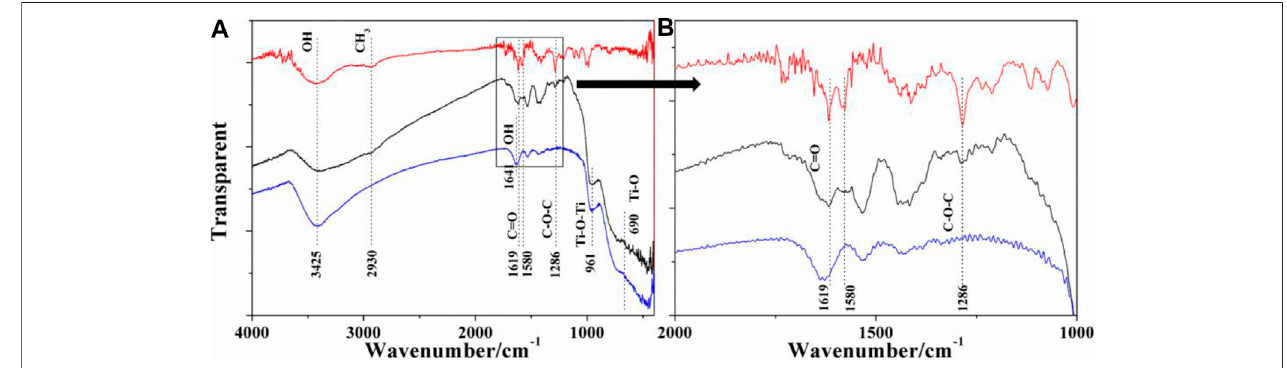
FIGURE 4 | (A) FT-IR spectra of TiO 2 (blue), DOX – TiO 2 (black), and pure DOX (red). (B) magni fi cation of rectangular box in (A) .